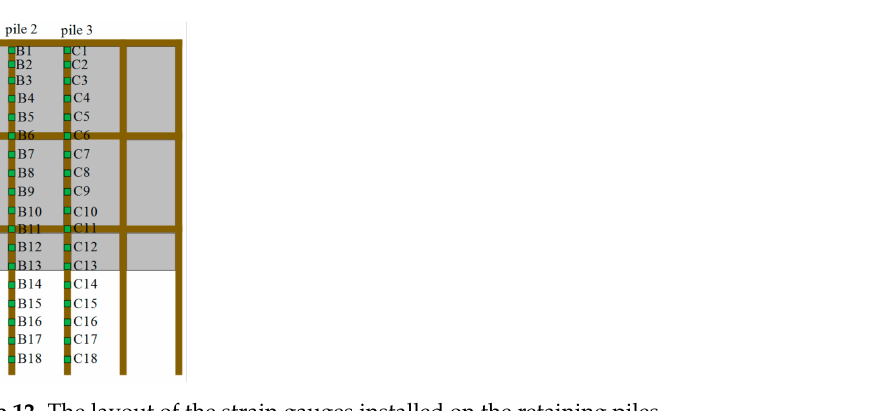
Figure 12. The layout of the strain gauges installed on the retaining piles.